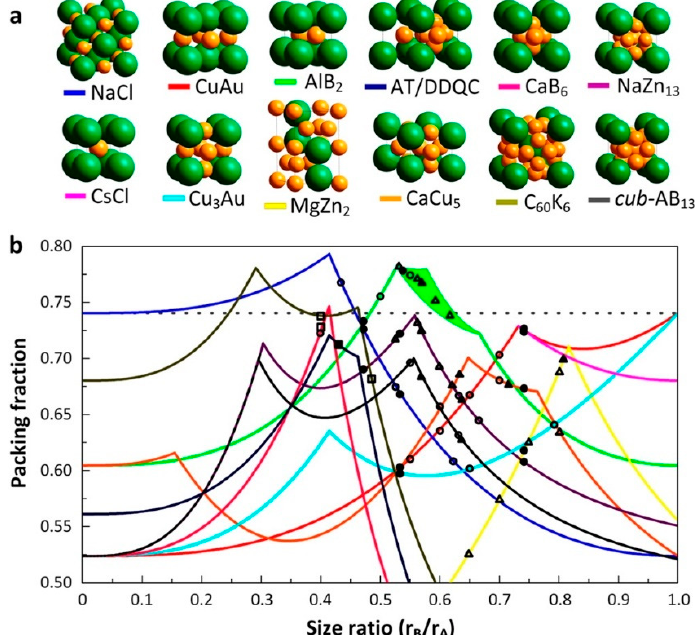
Figure 5. ( a ) Illustrations of different types of BNSL packing symmetries. ( b ) Phase diagram showing the packing fraction of BNSLs as a function of size ratio. (Reproduced with permission from [22]. Copyright American Chemical Society, 2015).